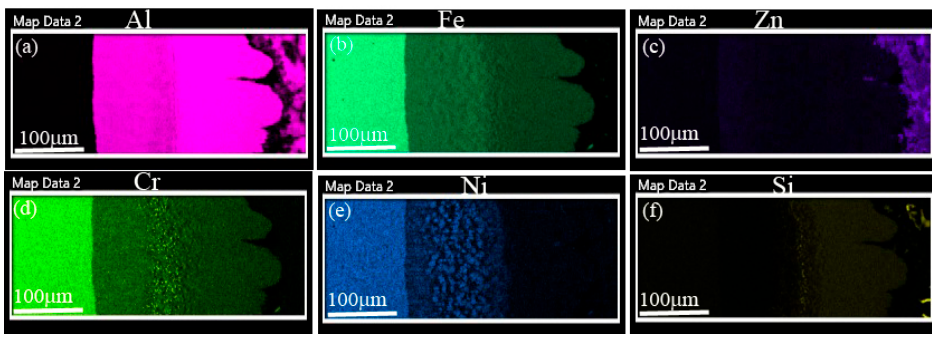
Figure 13. Elemental mapping of the SS, AL-1 and AL-2 obtained using EDS technique. ( a ). Al, ( b ). Fe, ( c ). Zn, ( d ). Cr, ( e ). Ni, ( f ). Si mapes. ( c ). Zn, ( d ). Cr, ( e ). Ni, ( f ). Si